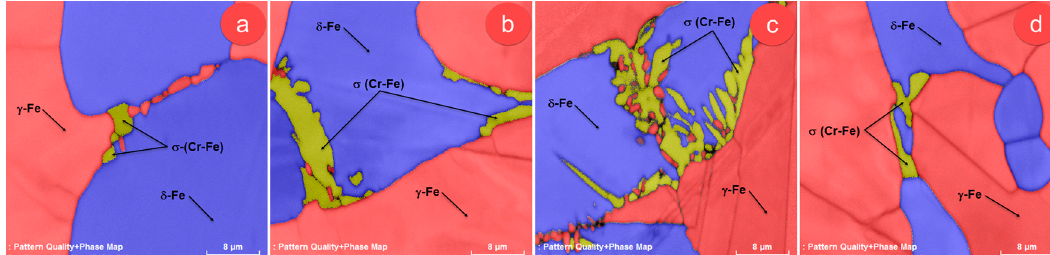
Figure 4. SEM-EBSD images of composite phases map distribution for all detected phases in the case of: ( a ) as-forged UNS S32750/1.4410/F53 SDSS alloy; ( b ) solution-treated (ST) at 800 °C for 0.6 ks; ( c ) ST at 900 °C for 0.6 ks; ( d ) ST at 1000 °C for 0.6 ks.